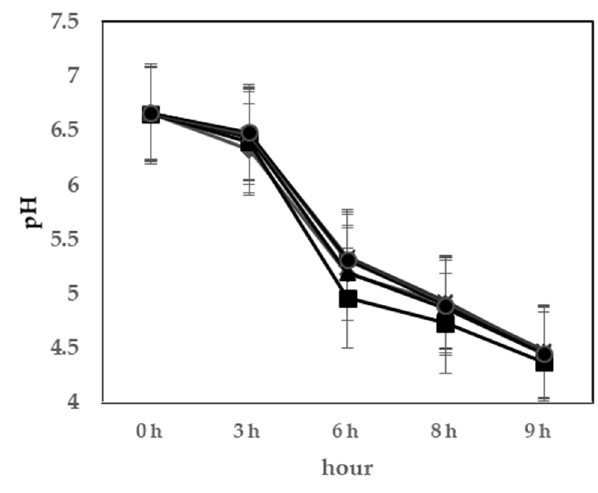
Figure 1. Changes in pH during fermentation at 40 °C. ◆ , control yoghurt without probiotics (C); ■ , L. rhamnosus GG KCTC 12202BP(T1); ▲ , L. plantarum KU15003 (T2); ✕ , L. plantarum KU15031(T3); ✳ , L. plantarum NK181(T4); ● , L. delbrueckii KU200171(T5).